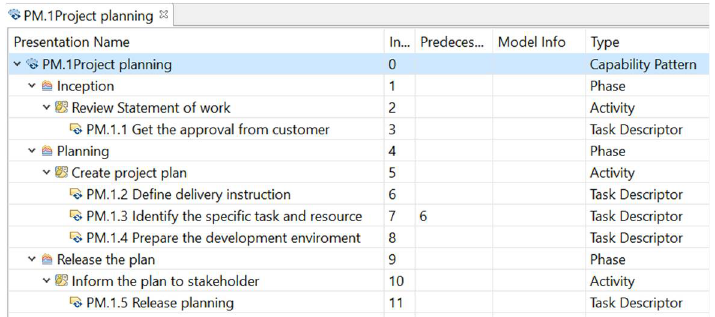
Figure 12. PM.1 (project planning) capability pattern.